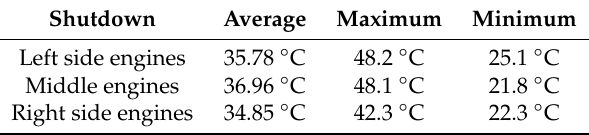
Table 9. Temperatures at Section Z = 5.5